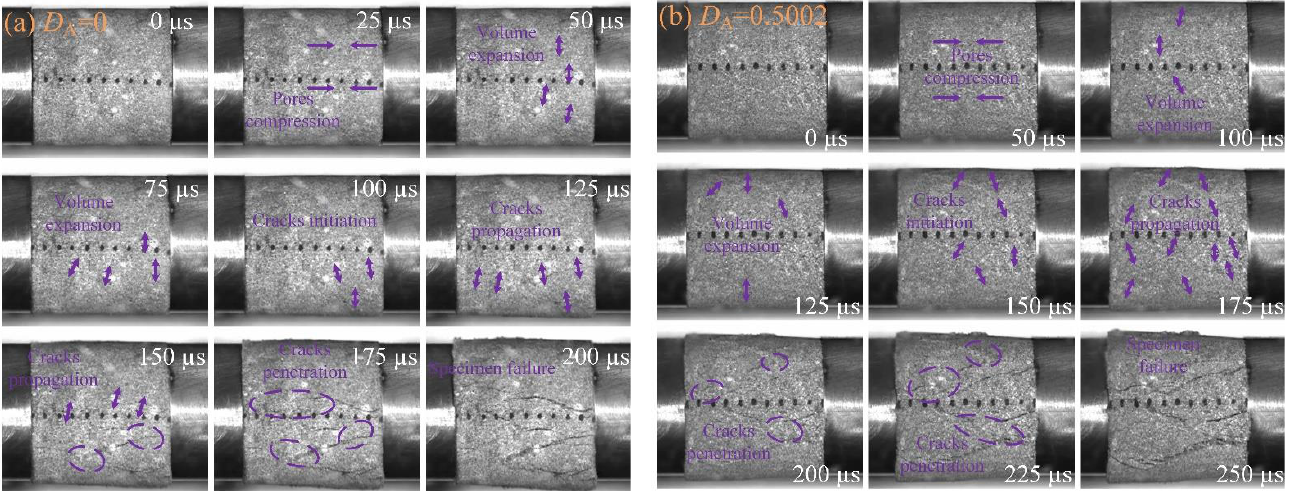
= 0 . 5002 D . Figure 13. Failure process of sandstone specimens: ( a ) D = A A